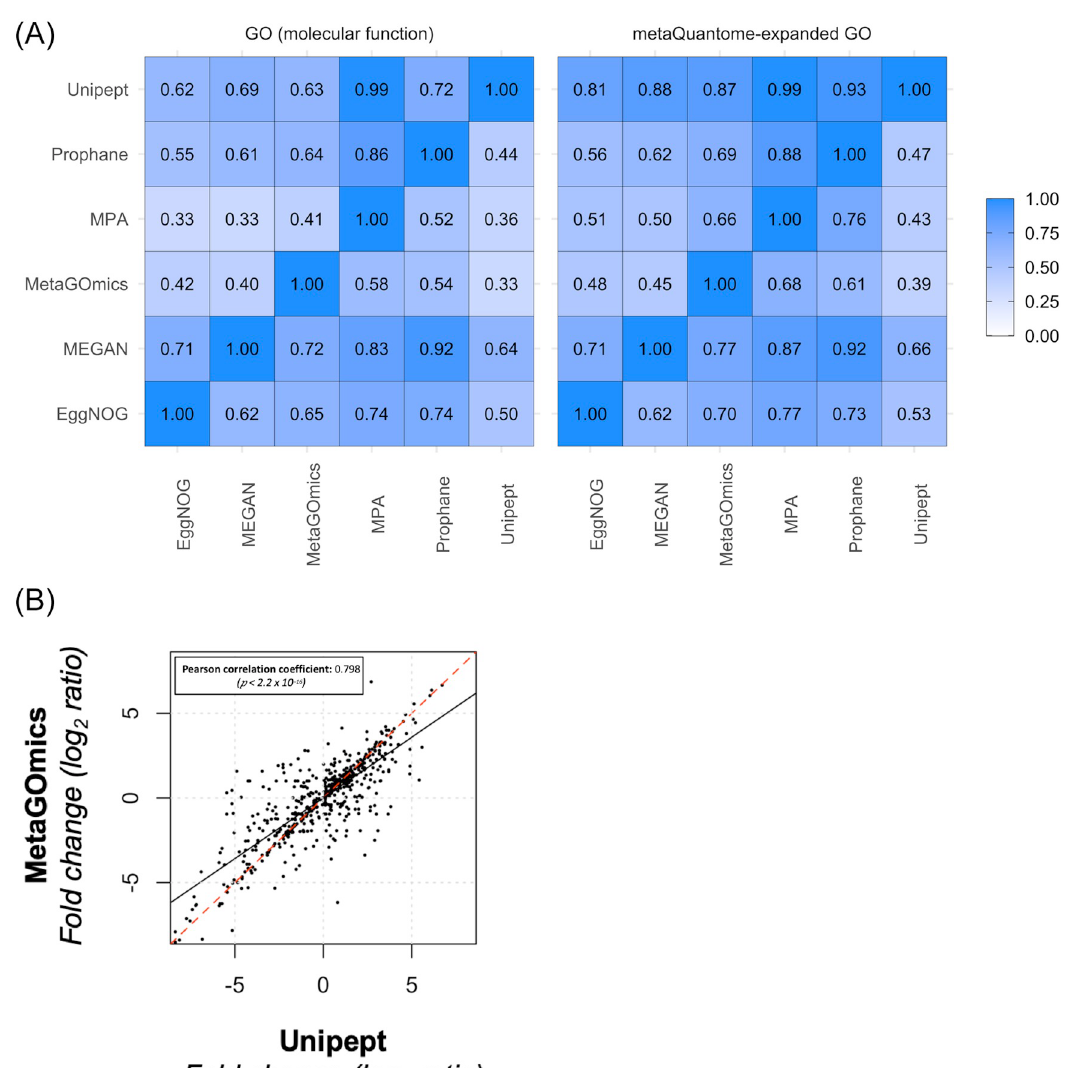
scenario (Fig 2A left panel). In the metaQuantome-expanded versions of these GO sets, there is an overall improvement, notably with tools that had the most expansion (MPA and Uni- pept). Relative to GO term comparison, expanded GO term comparison shows an improve- ment due to an expanded representation of each term (Fig 2A right panel). The same overlap analysis was performed for all GO term ontologies, biological process GO terms, and cellular